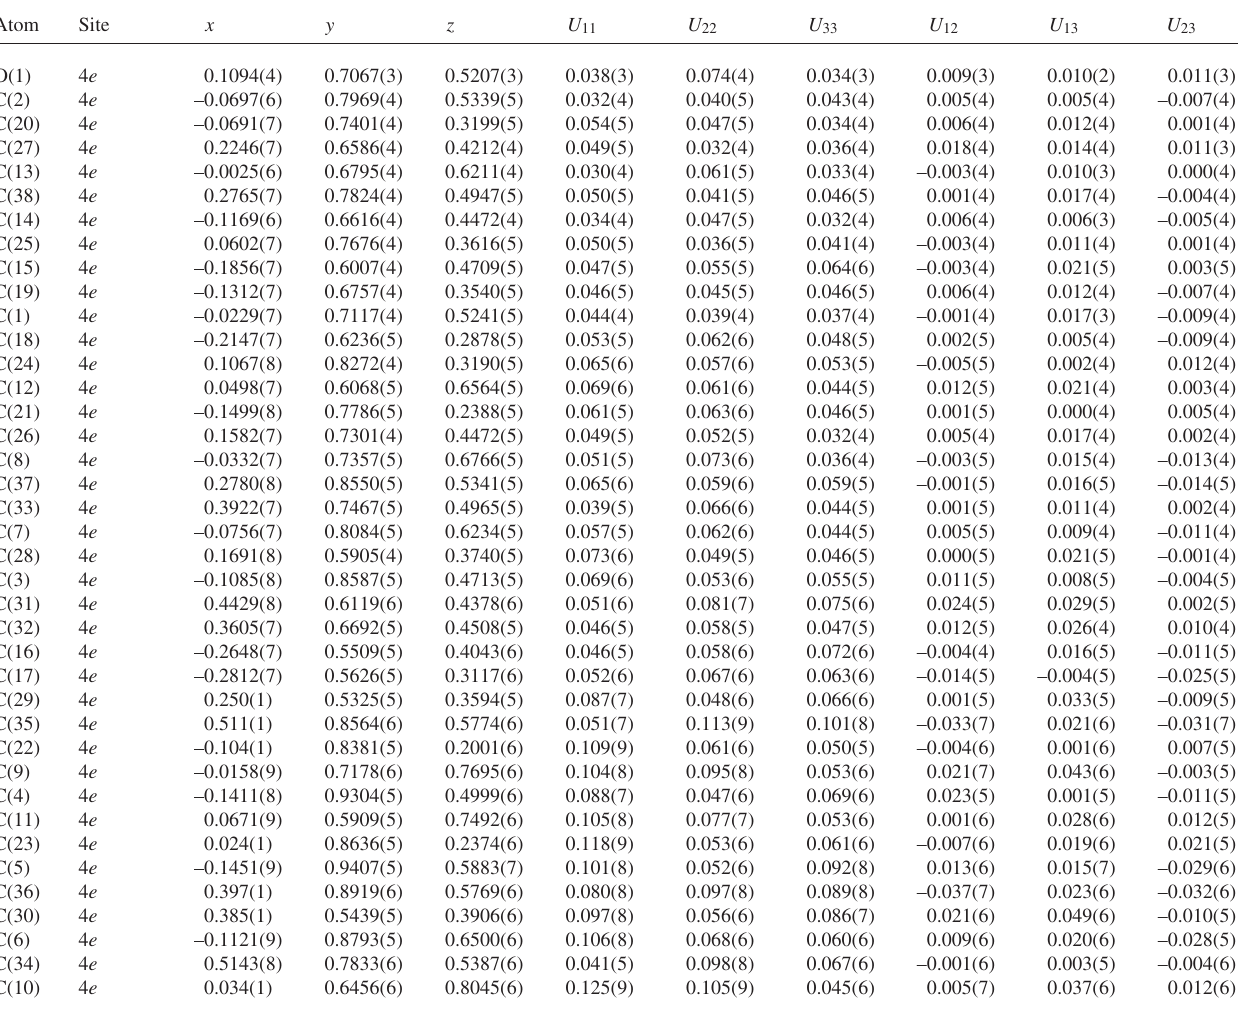
Table 3. Atomic coordinates and displacement parameters (in Å 2 )